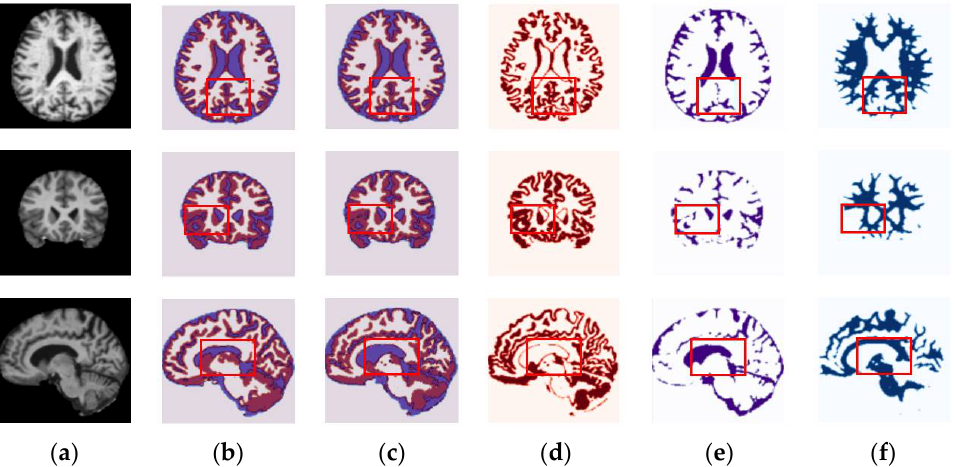
Figure 4. Randomly chosen test samples from brain MRI scans, showing segmentation results of the proposed method in all planes for the OASIS dataset: ( a ) original input images, ( b ) ground-truth maps, ( c ) predicted maps obtained under the proposed method, ( d ) predicted binary maps of GM, ( e ) predicted binary maps of CSF, and ( f ) predicted binary maps of WM.